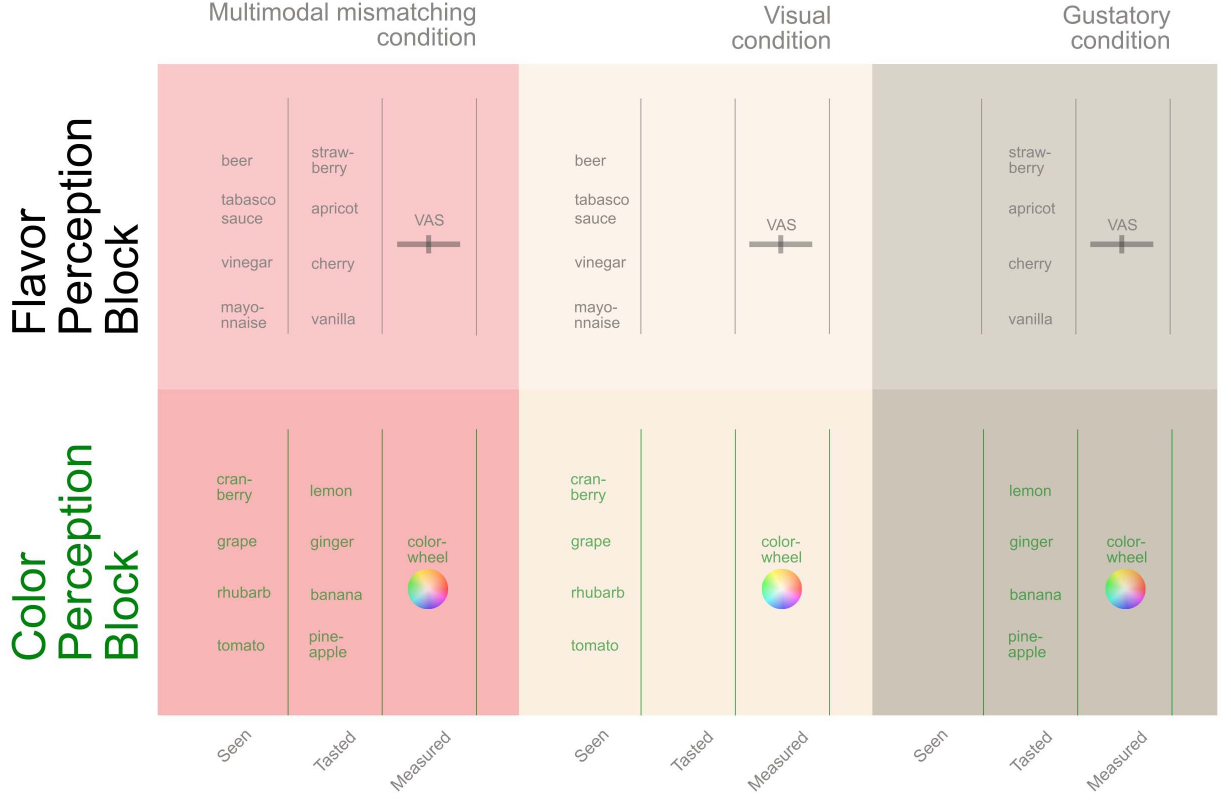
FIGURE 2 | Overview of the experimental design of the here reported experiment showing both the flavor perception and the color perception blocks, as well as the stimuli presented for each task. The blocks were presented in a counterbalanced